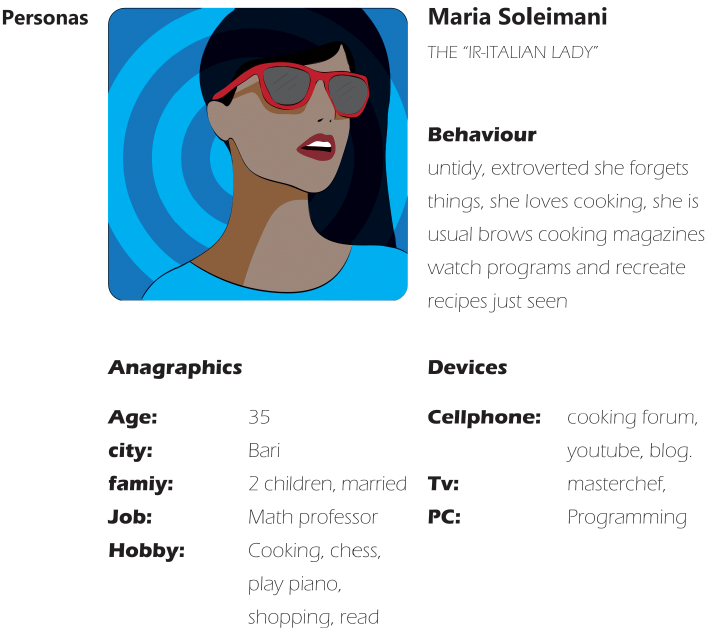
Figure 4. Example of a persona. Maria is represented by her anagraphic data (i.e., age, city, family, and job), behavior, hobbies, and devices that she uses, including the actions that she performs.